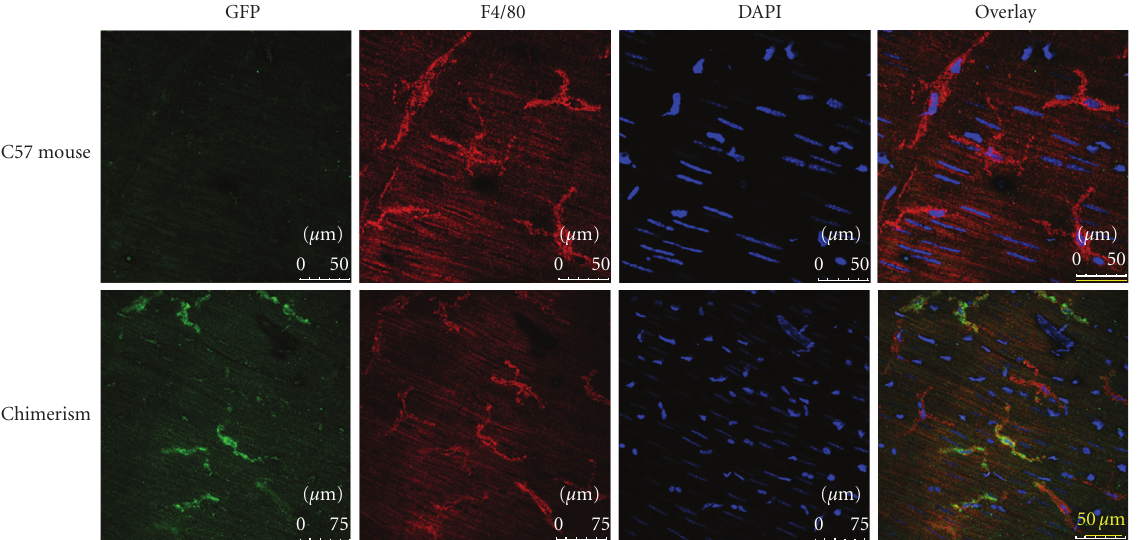
Figure 3: Whole mount preparation of small intestine from both normal C57 mouse and chimeric mouse. in this figure, donor’s BMDCs were detected by GFP antibody. Macrophages were demonstrated by their specific marker F4/80. Upper panel: C57 mouse was used as normal control, in which all the macrophages were negative for GFP antibody. Bar = 50 μ m. Lower panel: in the chimerism some macrophages were double positive for GFP and F4/80, suggesting that they were derived from the infused donor’s BMDCs. GFP + /F4/80 + cells were mainly found at the deep myenteric plexus and they were scattered in this layer, which distinguished them from ICCs. Bar = 50 μ m.